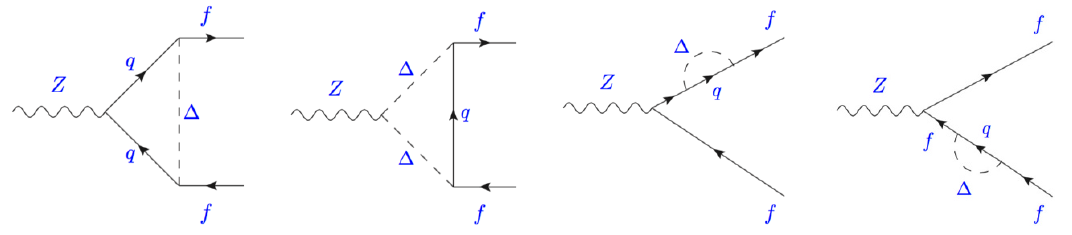
f (cid:22) f decay amplitude generated in our R 2 model, where the ! u; c; b; t depending on the LQ state running in the loop, 2 f g b (cid:22) b !